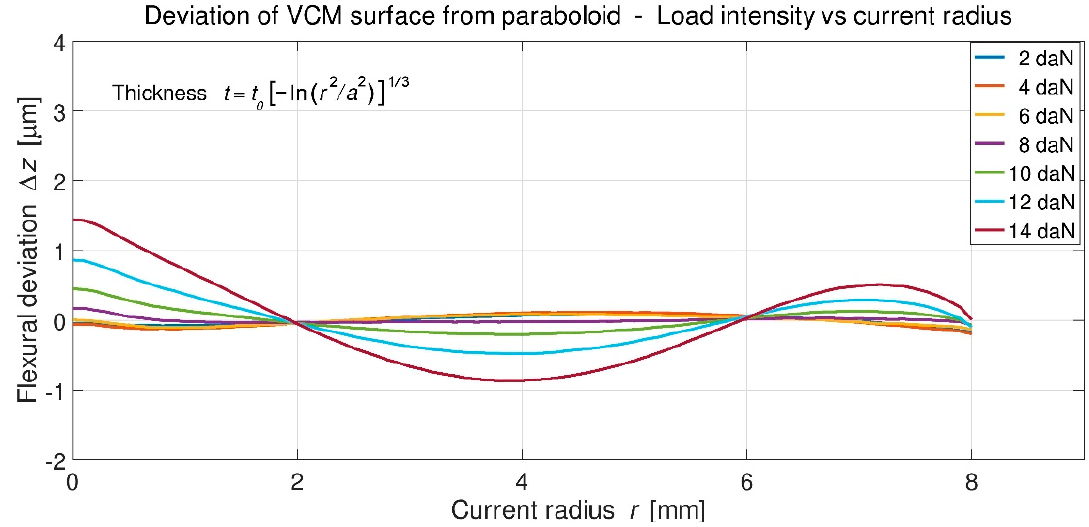
Figure 4. Least mean ‐ square flexural deviations. Thickness distribution as before.